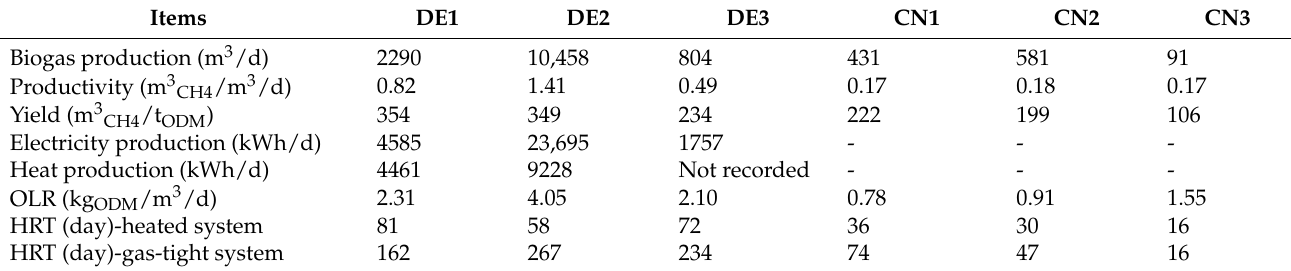
Table 3. Outputs and performance of selected German (DE) and Chinese (CN) biogas